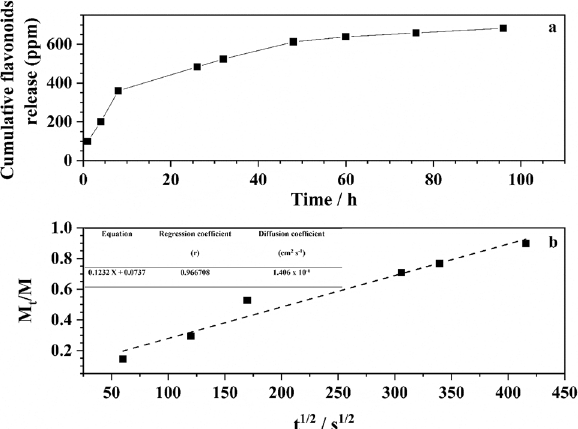
Figure 5. ( a ) Proportion of released flavonoid for sample GIC-BPE, ( b ) diffusion equation, regression coefficients, diffusion coefficient for the flavonoids release from GIC-BPE, and diffusion plot for flavonoids extracted from the GIC-BPE sample.